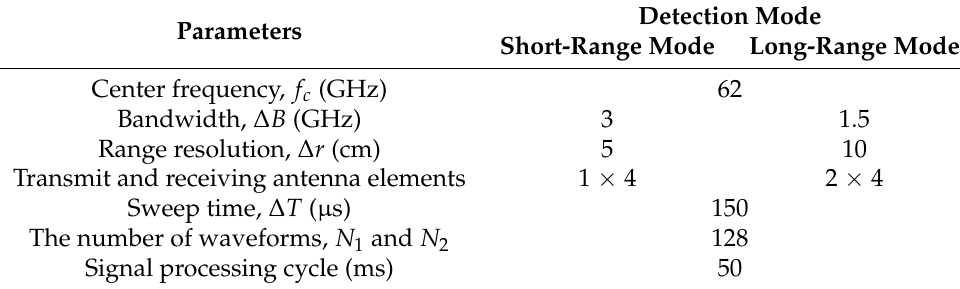
Table 1. Specifications of our FMCW Radar